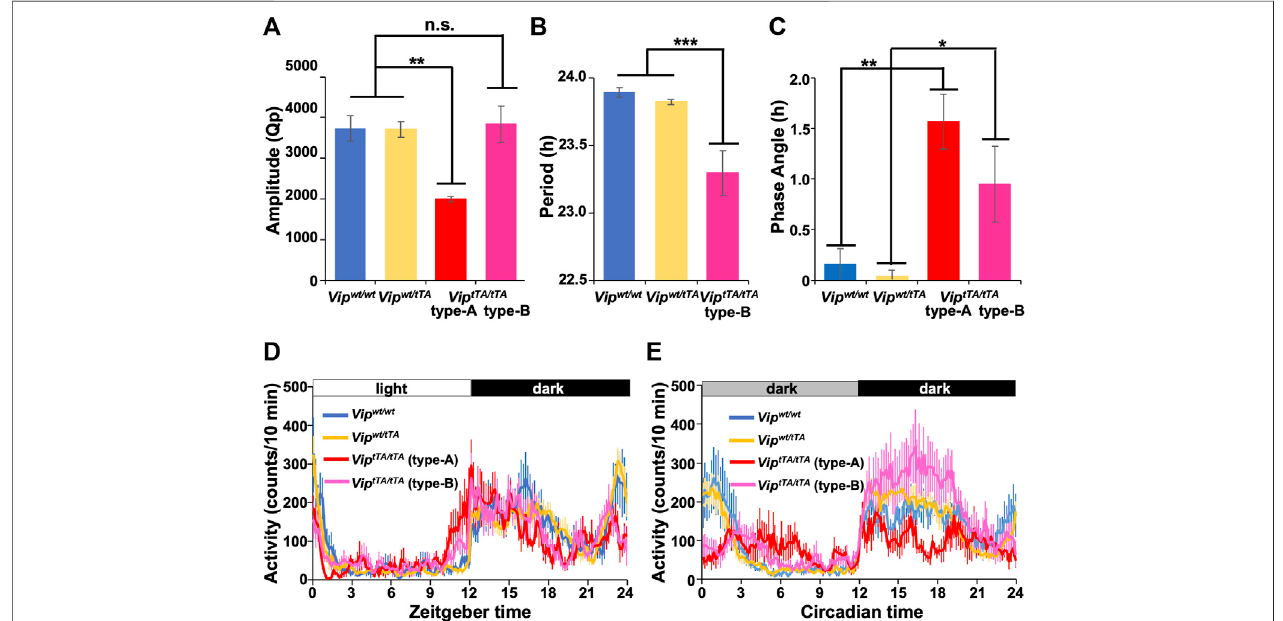
FIGURE 4 | Vip tTA/tTA mice show impaired circadian rhythms. (A) The circadian amplitude of rhythms was signi fi cantly reduced in type-A Vip tTA/tTA mice (n = 5) compared to Vip wt/wt (n = 7), Vip wt/tTA (n = 12), and type-B Vip tTA/tTA (n = 7) mice. Bars show circadian amplitudes at the dominant period as determined by χ 2 periodogram analysis (Qp values). (B) Free-running period was shortened in type-B Vip tTA/tTA mice. (C) Phase angle of entrainment under LD. (D – E) Daily pro fi les of circadian behavioral rhythms under LD (D) or DD (E) . Error bars indicate SEM. *, p < 0.05; **, p < 0.005; ***, p < 0.001 by one-way ANOVA followed by post-hoc Tukey